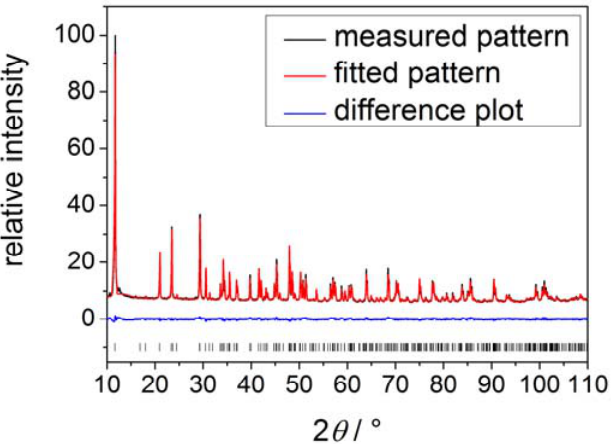
Figure 13. X-ray powder pattern. Pure calcium hydrogen phosphate in the brushite phase was